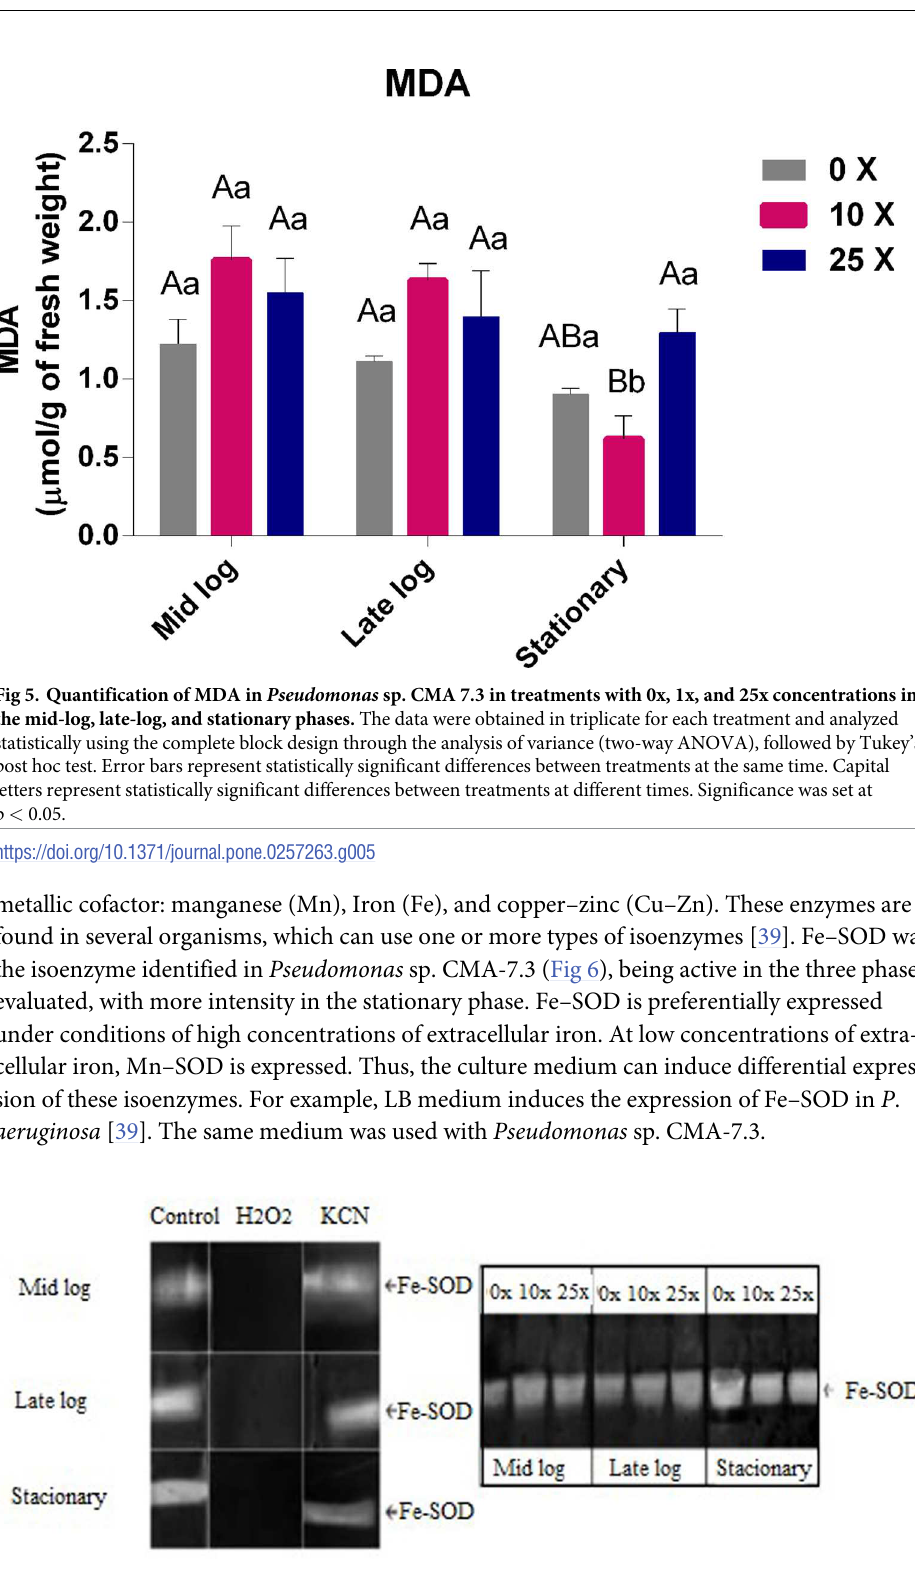
Fig 6. Characterization of SOD isoforms in PAGE, which were obtained from the extracts of Pseudomonas sp. CMA 7.3 grown in LB, treated with KCN and H 2 O 2 , in the mid-log, late-log, and stationary incubation